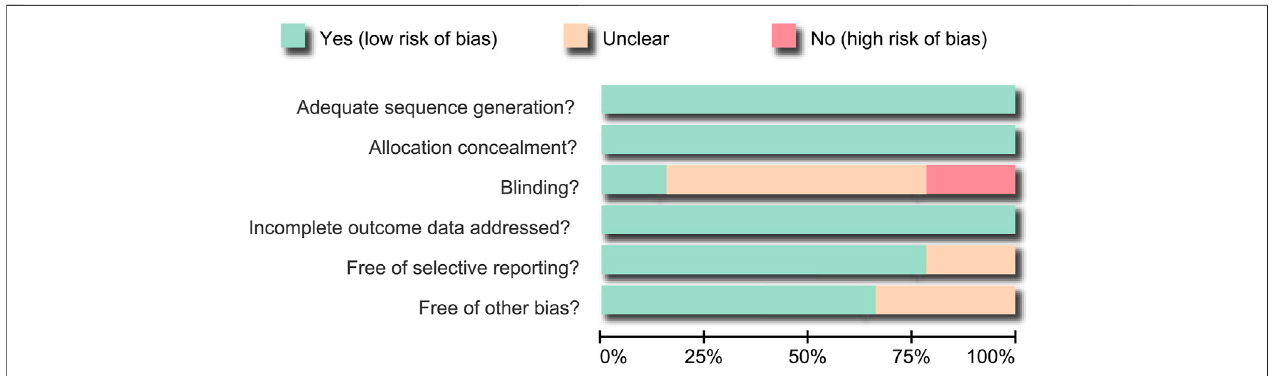
FIGURE 1 | Bias risk assessment using the Cochrane Collaboration ’ s tool. Fourteen eligible randomized controlled trials were analyzed in this NMA.